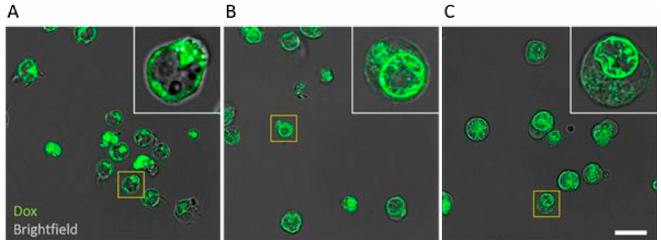
Figure 7. Confocal fluorescence microscopy of the middle section of the cells (overlay of the dox channel in green and Brightfield in gray) of CEM/ADR5000 cells treated with ( A ) + 20 µM doxo, ( B ) + 20 µM dox + 4 × IC 50 compound 5 and ( C ) + 20 µM doxo + 100 µM verapamil. Scalebar is set to 20 µm.